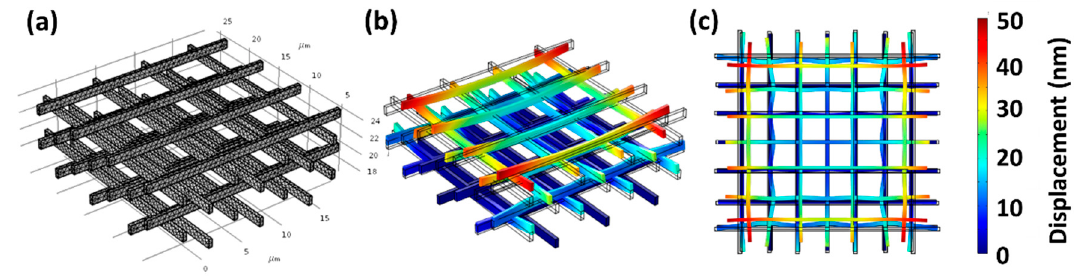
Figure 11. ( a ) Mesh configuration and ( b , c ) finite element analysis (FEA) simulation of shrinkage-induced deformation for 24 × 24 × 8 μ m 3 log-pile block fabricated in IP-Dip with 6.2 μ m line spacing. See text for